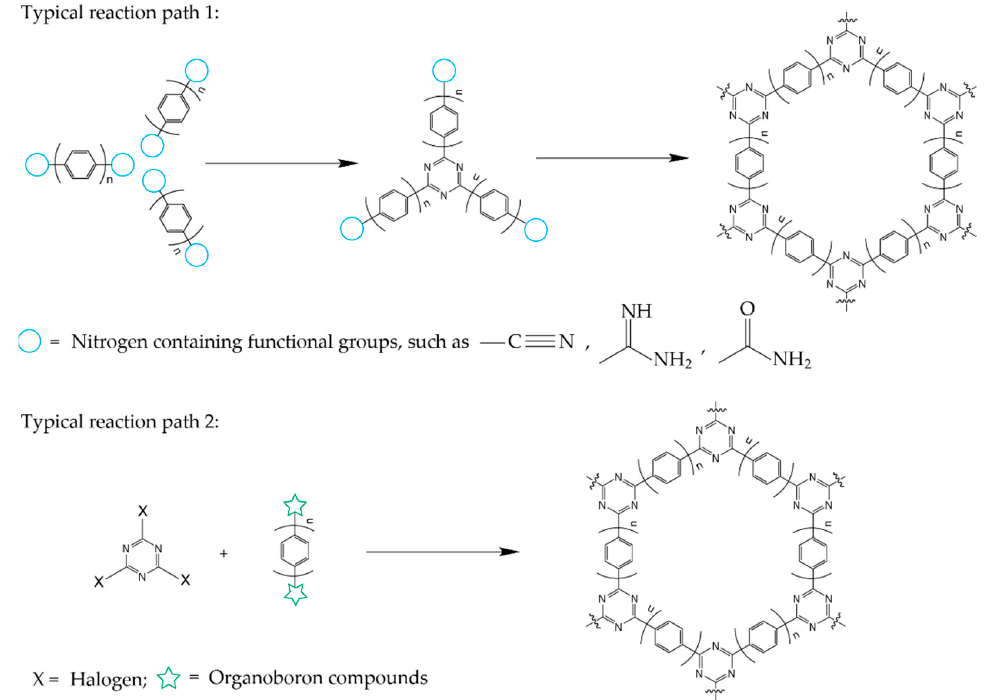
Figure 2. Typical reaction paths for the synthesis of CTFs.